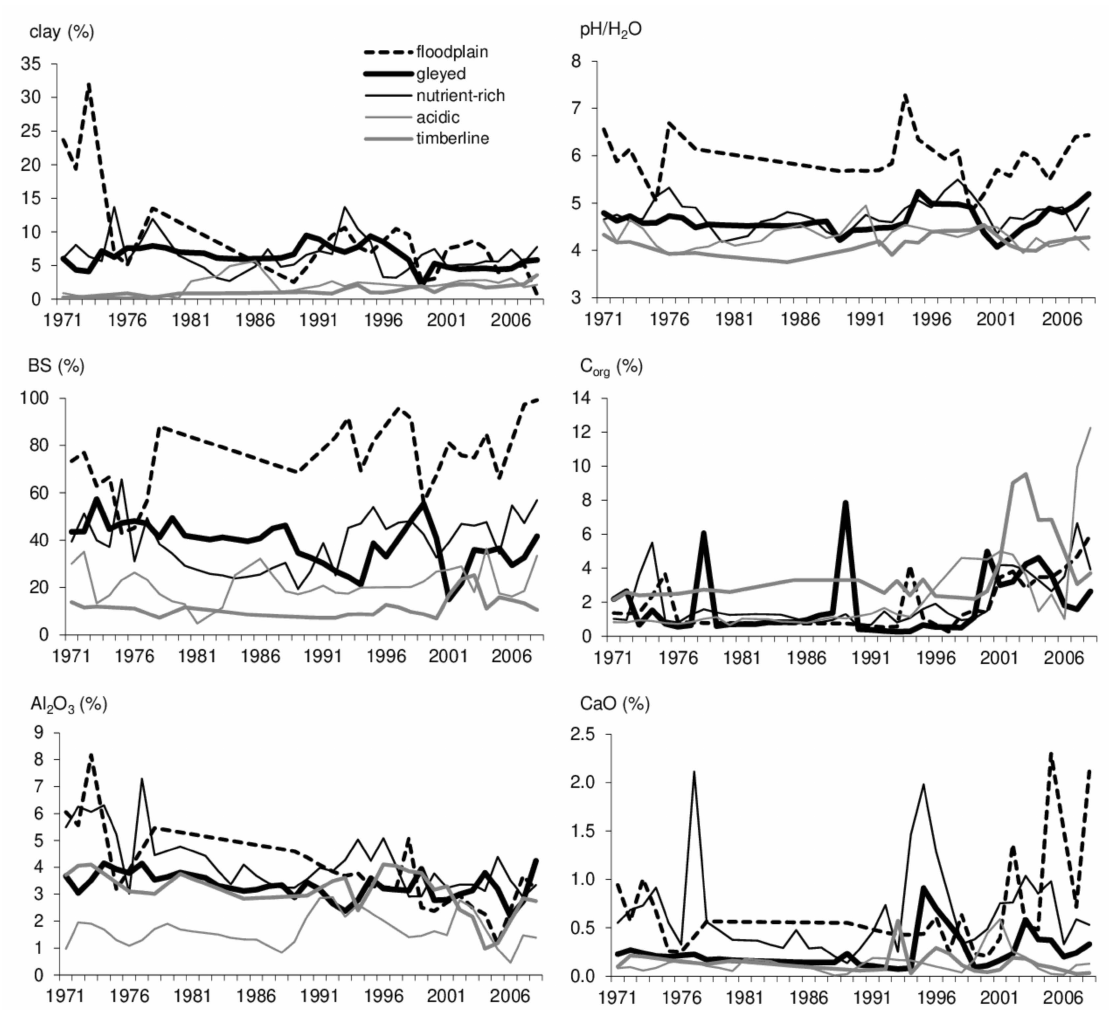
Figure 3. Development of soil series characteristics clay content, pH/H 2 O, base saturation (BS), organic carbon (C org ) and total A 2 O 3 and CaO